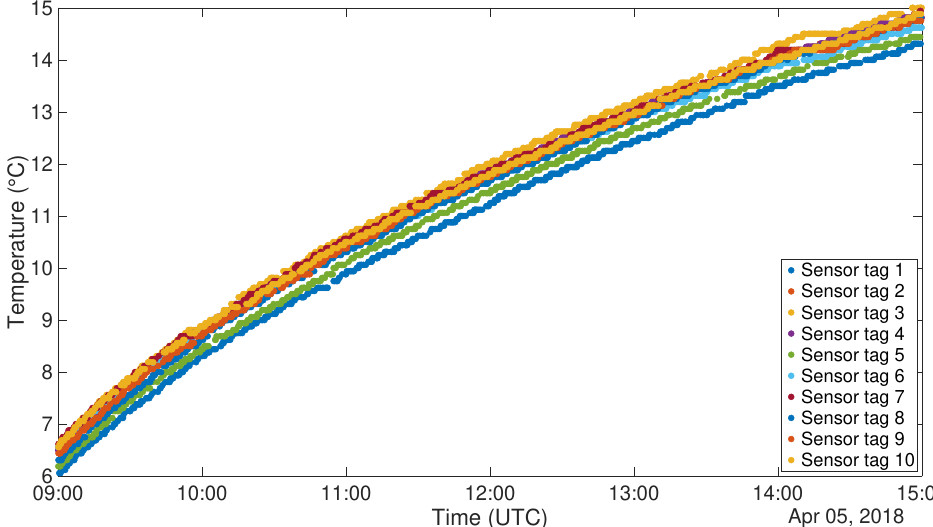
Figure 7. RFID Refrigerator test - Temperature ( ◦ C).